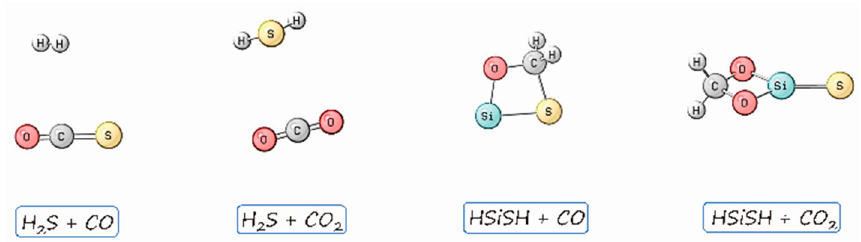
Molecules 2021 , 26 , x FOR PEER REVIEW Figure 1. Global minima obtained for the reactions of H 2 S and HSiSH with CO x ( x = 1, 2).